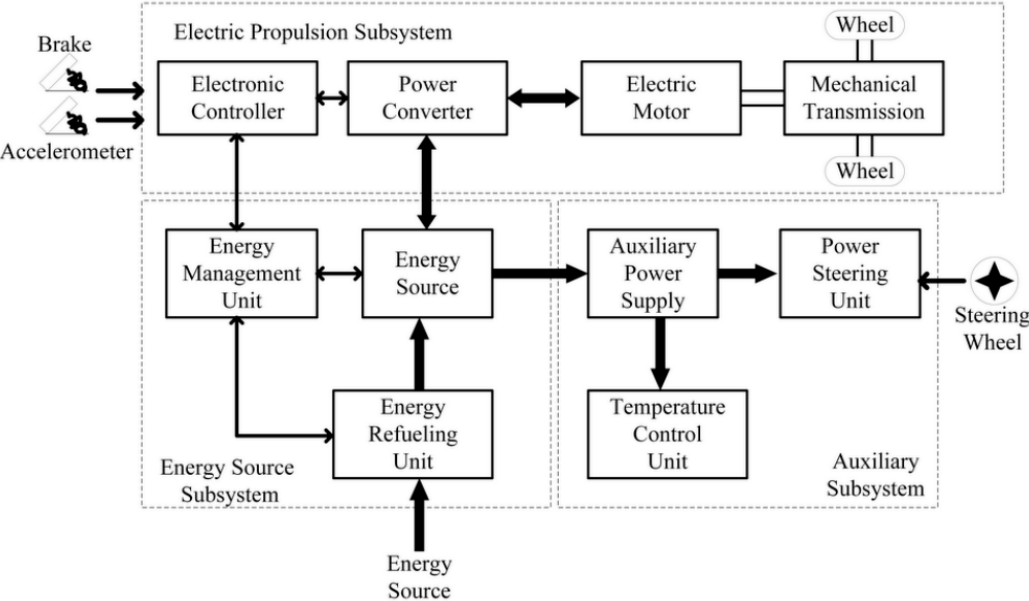
Figure 10. EV subsystems. Adapted from [4].